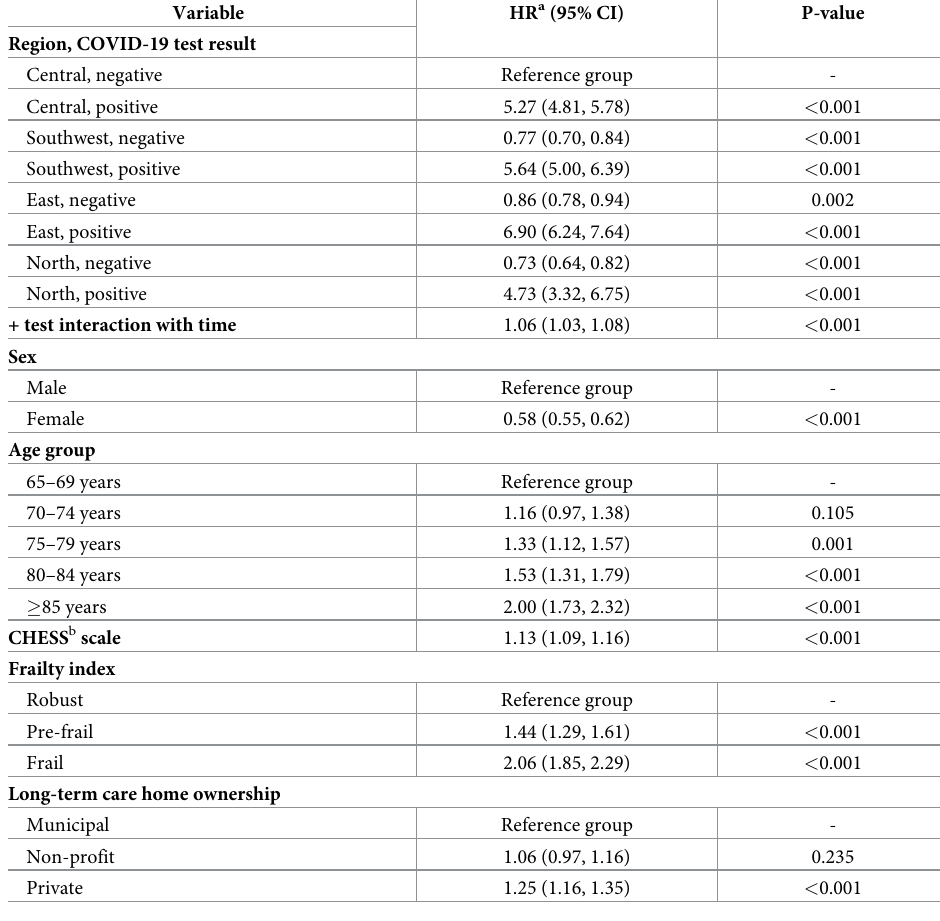
Table 3. Predictors of death within 30 Days after COVID-19